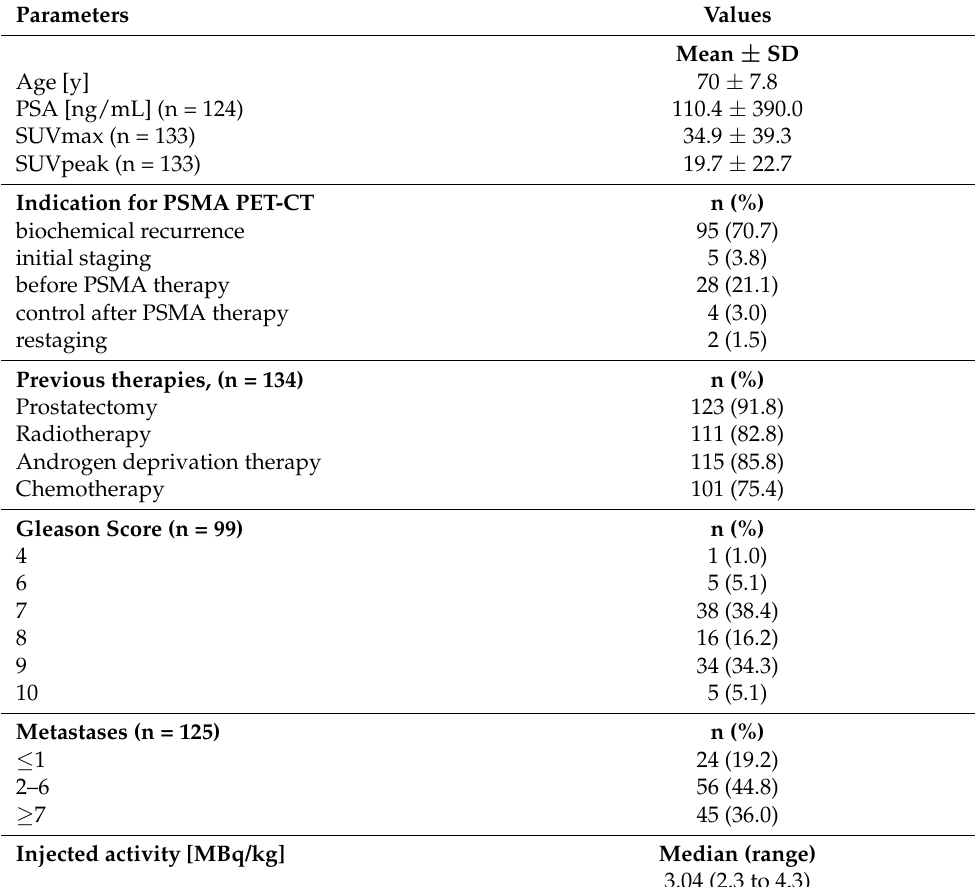
Table 1. Characteristics of the 134